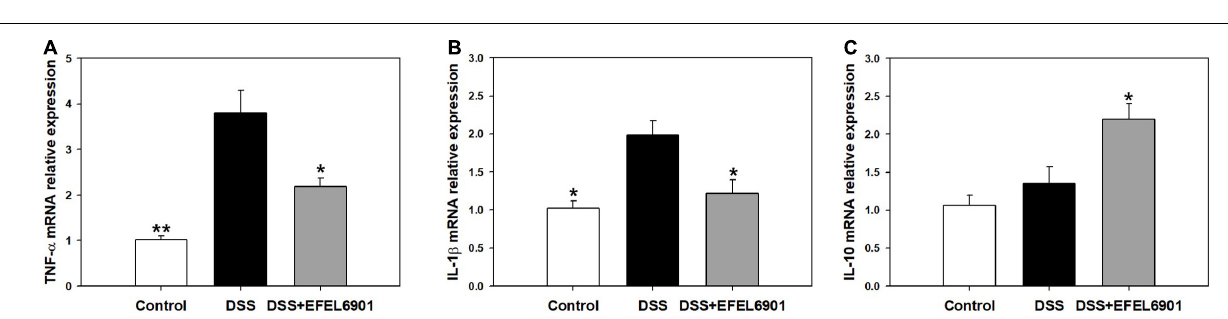
FIGURE 6 | Effects of Limosilactobacillus reuteri EFEL6901 strain on cytokine levels in mouse colon. Quantification of TNF- α (A) , IL-1 β (B) , and IL-10 (C) mRNA expression levels in the colon. Expressed mRNA levels of cytokines were determined by real-time PCR. Results are expressed as means ± standard ( n = 5). Significant differences are presented with the DSS group: * p < 0.05; ** p <